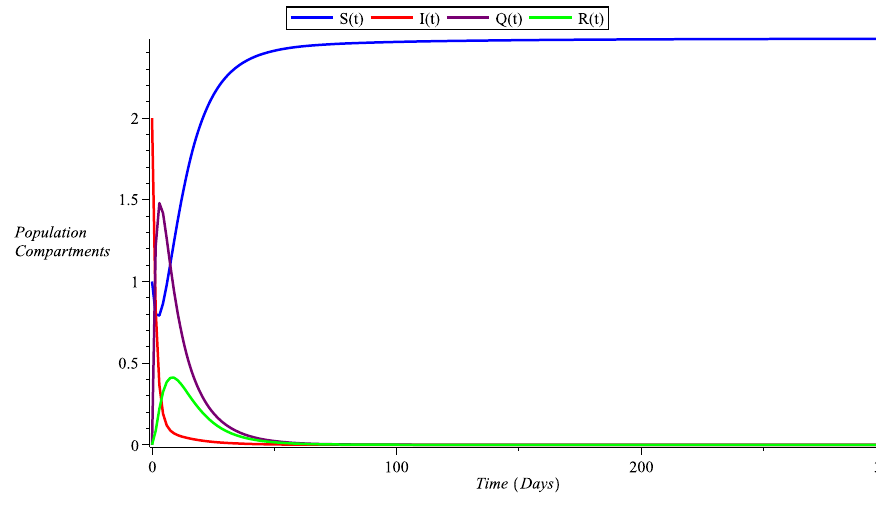
Fig. 6. Time-course solution with strict social isolation and total lockdown , σ = 0 . 70 , η = 0 . 0